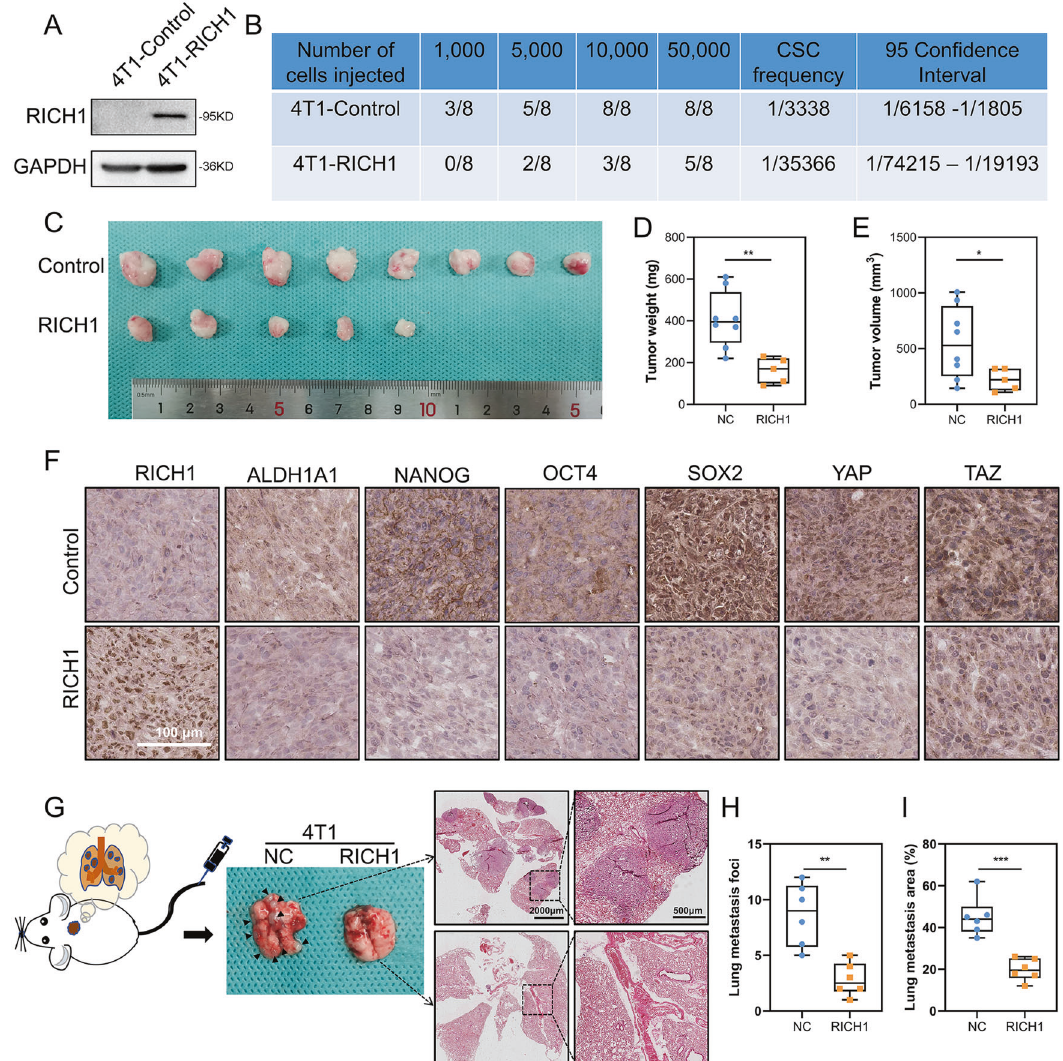
Fig. 6 RICH1 inhibits stem cell-like properties of breast cancer in vivo. A RICH1 overexpression in 4T1 cells. B In vivo tumor formation of the mice injected with serial dilutions of 4T1-Control and 4T1-RICH1 cells. C Tumor images of mice injected with 50,000 control and RICH1- overexpressing 4T1 cells. D, E . Tumor weights ( D ) and volumes ( E ) of mice injected with 50,000 control and RICH1-overexpressing 4T1 cells. F Representative IHC staining results of tumor samples. G Representative visualized lung metastasis models and HE staining of lung metastasis specimen (arrows: metastatic foci). H Number of metastatic foci of control and RICH1-overexpressing 4T1 cells. I Lung metastasis area of control and RICH1-overexpressing 4T1 cells. Statistical signi fi cance was determined by two-tailed unpaired t -test. Abbreviation: * p < 0.05; ** p < 0.01; *** p <